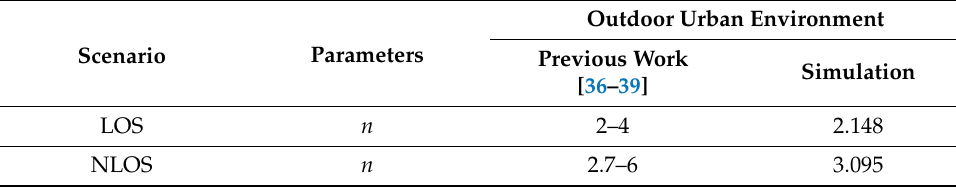
Figure 5. Obtained path loss values from ray tracer. Table 3. Path loss parameters for simulation and previous works.